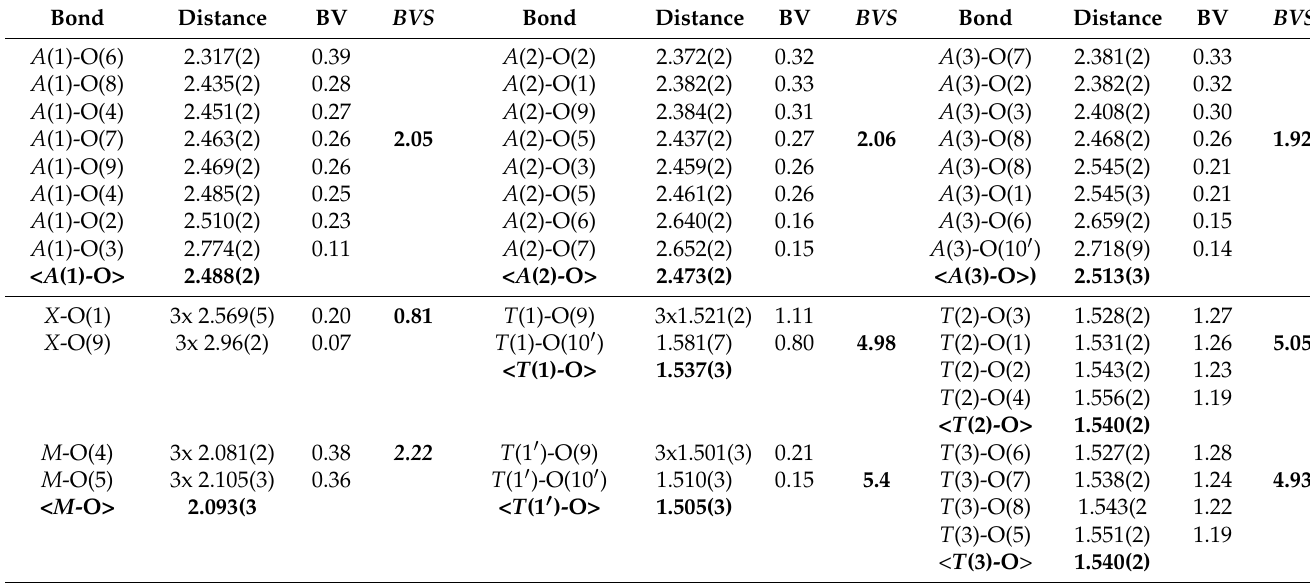
Table 5. Bond distances (Å) and bond valence/sum (BV/BVS, in valence units = v.u.) for the studied whitlockite (from XRD data). BV/BVS values for the A (2) and M sites calculated according to the single cationic occupancies (Table 3). Bond